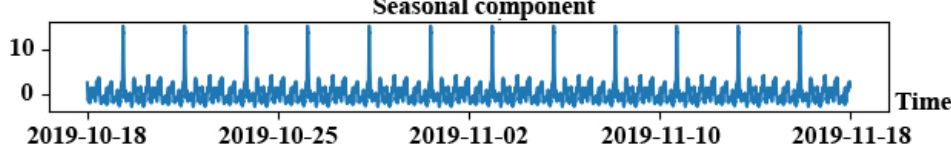
Figure 2. Seasonal components of KPI time series